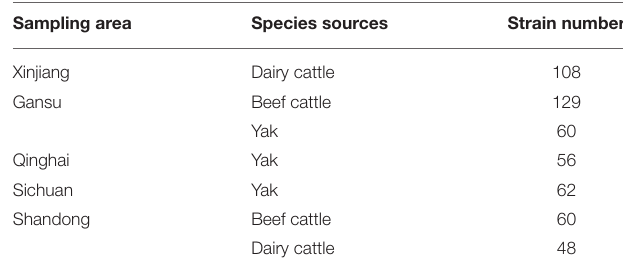
TABLE 1 | Sampling area, sources of species and strain number of E. coli